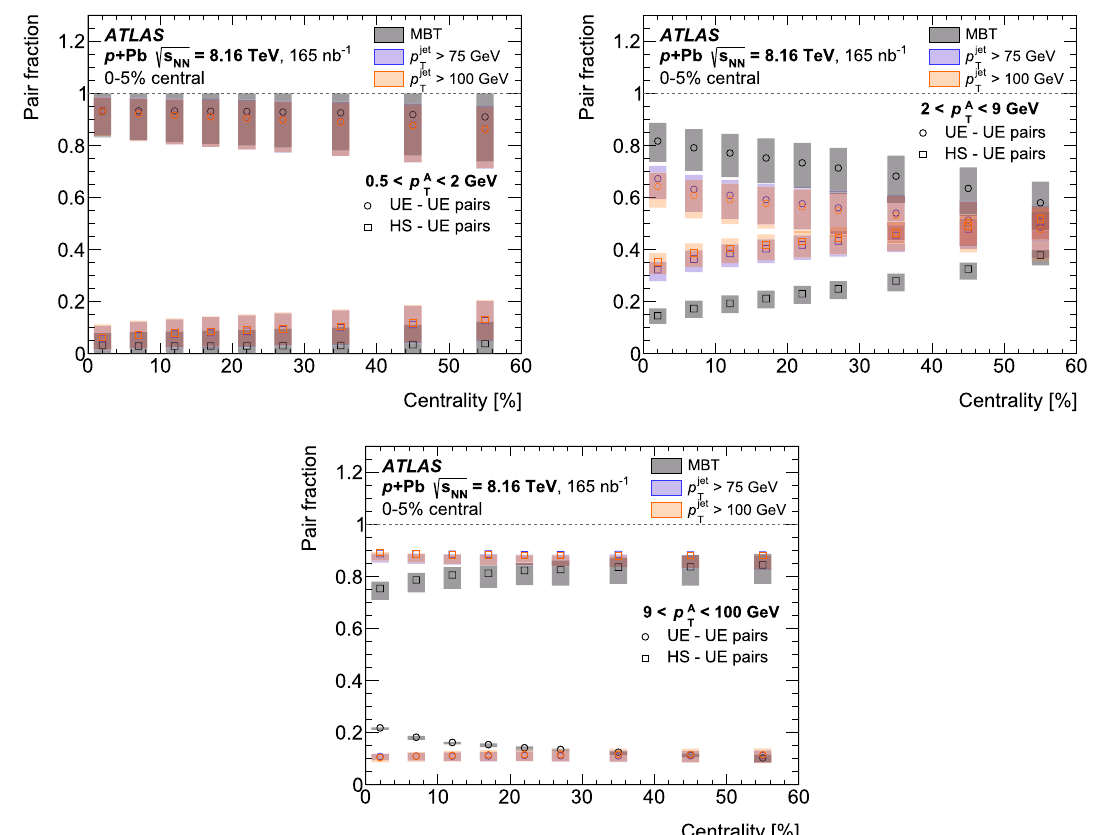
Fig. 12 Underlying event–underlying event (UE–UE) (open circles) and hard scatter–underlying event (HS–UE) (open squares) particle- pair yield composition fractions for MBT events (black), events with jet p T > 75 GeV (blue), and events with jet p T > 100 GeV (orange) plotted as a function of event centrality. The results are obtained in three